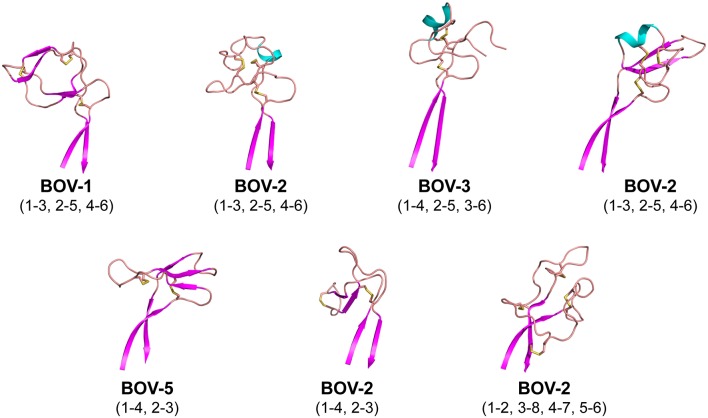
Cartoon representations of the knob structures on the distal tip of seven ultralong CDRH3s of bovine antibodies. β strands are colored magenta, α helices are colored cyan, and loops colored salmon. Sulfur atoms are shown in yellow to indicate disulfide bonds. Disulfide bond (cysteine pairing) configurations are in parentheses. Part of one loop in antibody BOV-3 was disordered in the crystal structure; this region is represented with a dashed line.